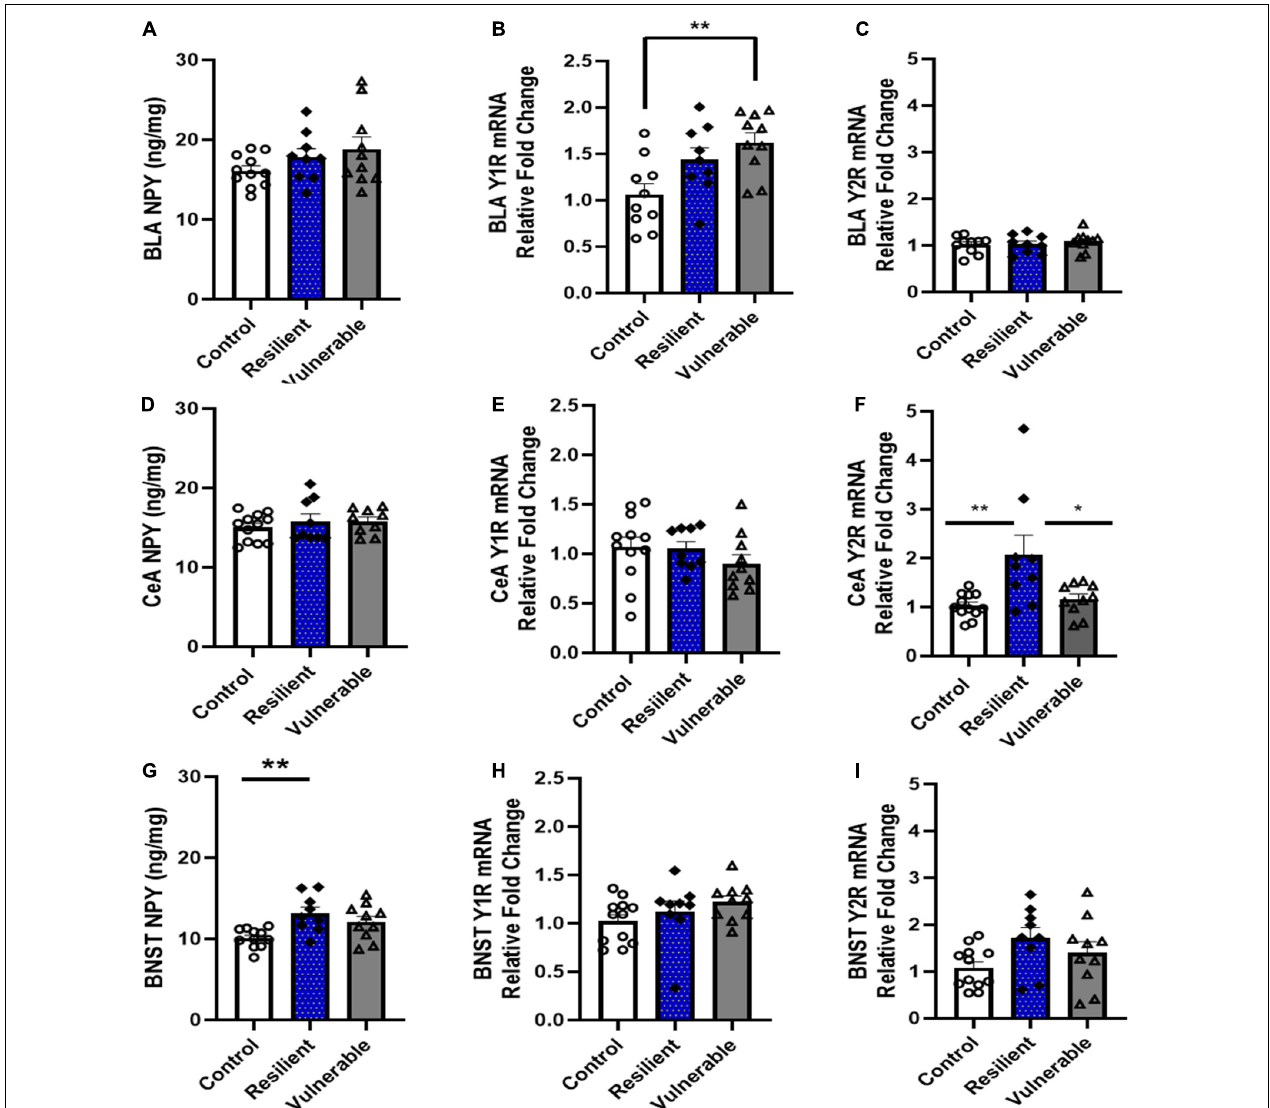
FIGURE 9 | Levels of NPY protein, Y1R mRNA, and Y2R mRNA in the BLA, CeA and BNST in control and SPS-exposed rats classified as vulnerable or resilient. Traumatic stress exposure differentially effected the NPY pathway in resilient and vulnerable rats in a brain region-specific manner. (A–C) In the basolateral amygdala (BLA), Y1 mRNA was higher in vulnerable compared to the control group. (D–F) In the central nucleus of the amygdala (CeA), resilient rats had higher Y2 mRNA levels than control and vulnerable groups. (G–I) In the bed nucleus stria terminalis (BNST), resilient rats had higher levels of NPY protein than the control group. Data are expressed as means ± SEM; Controls N = 12; resilient N = 9; vulnerable N = 10. Post hoc tests: * P < 0.05, ** P < 0.01.